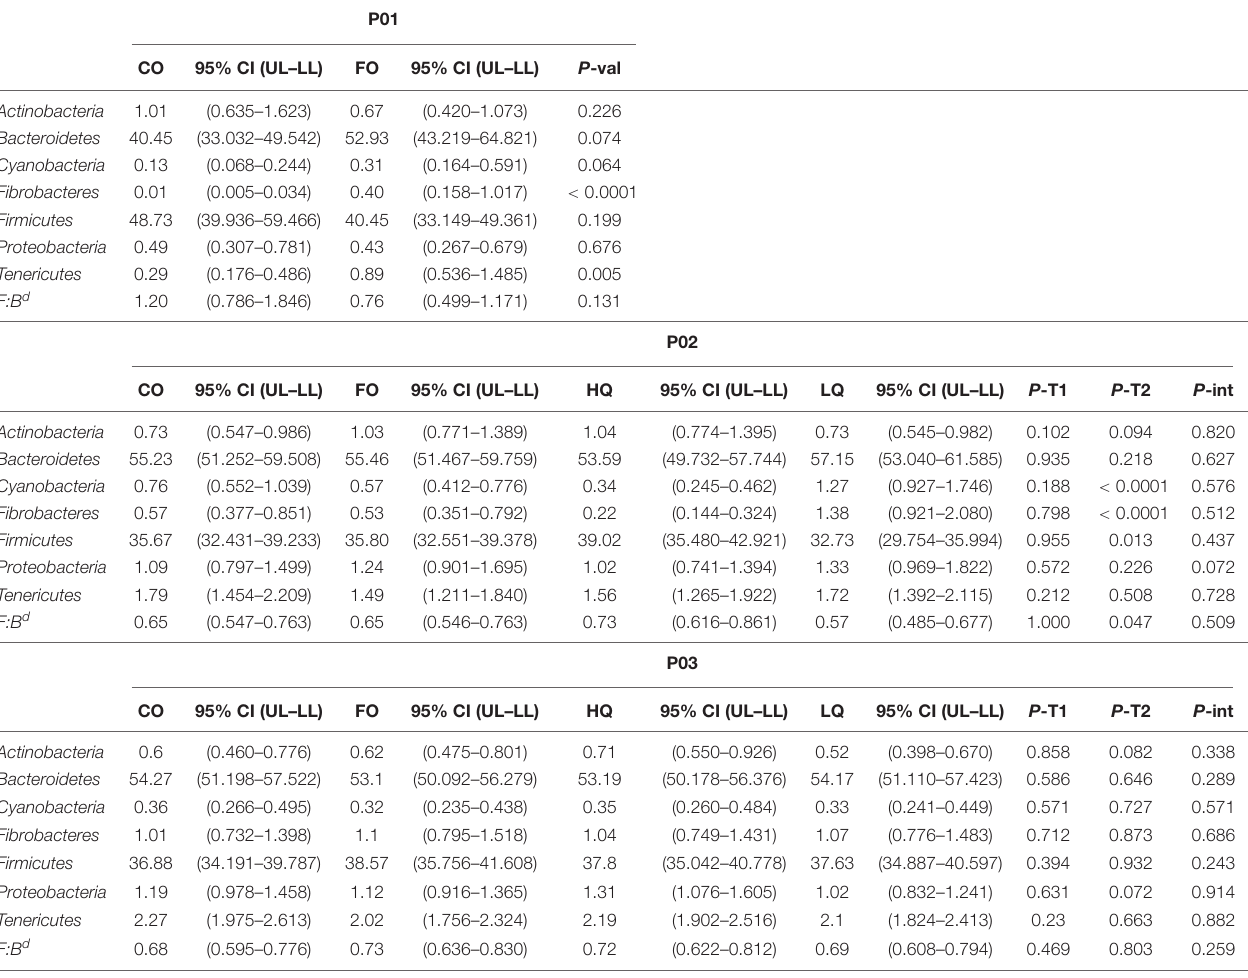
TABLE 3 | Effect of dietary treatments a on the abundant bacteria phylum b during the measurement phases: 1 (P01), 2 (P02), and 3 (P03) c